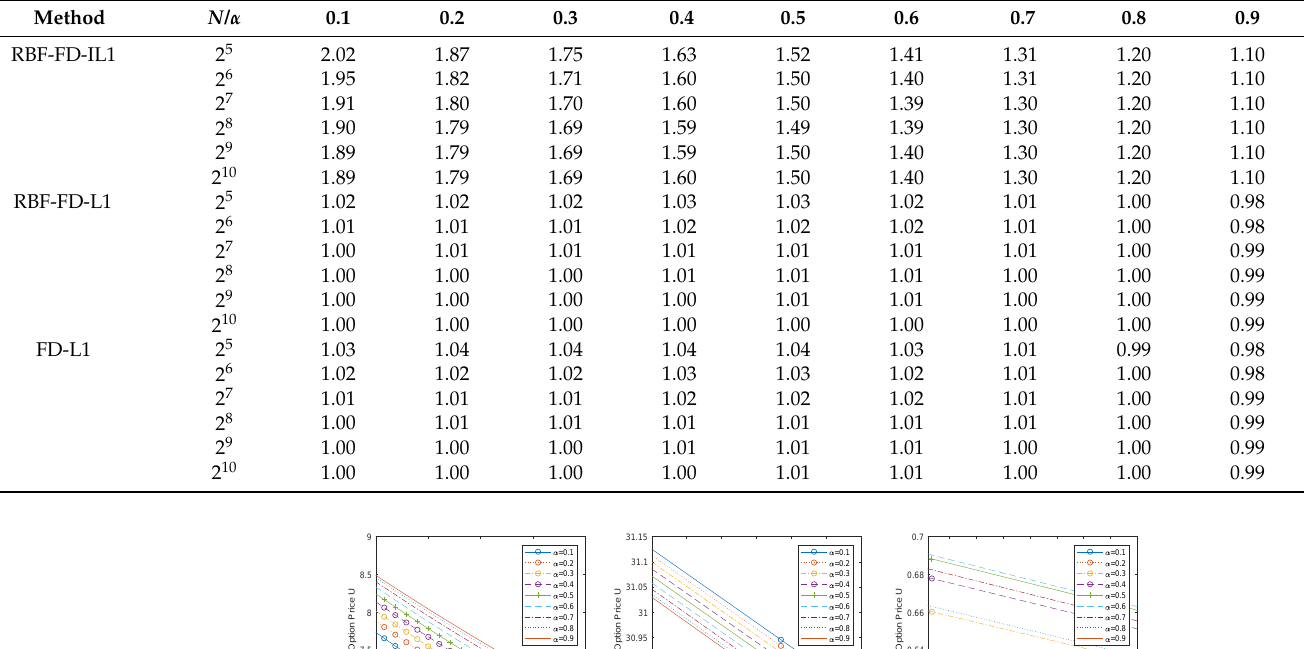
Table 3. The order of convergence for European put options using the RBF-FD-IL1, RBF-FD-L1 and FD-L1 methods with M = 2 9 .